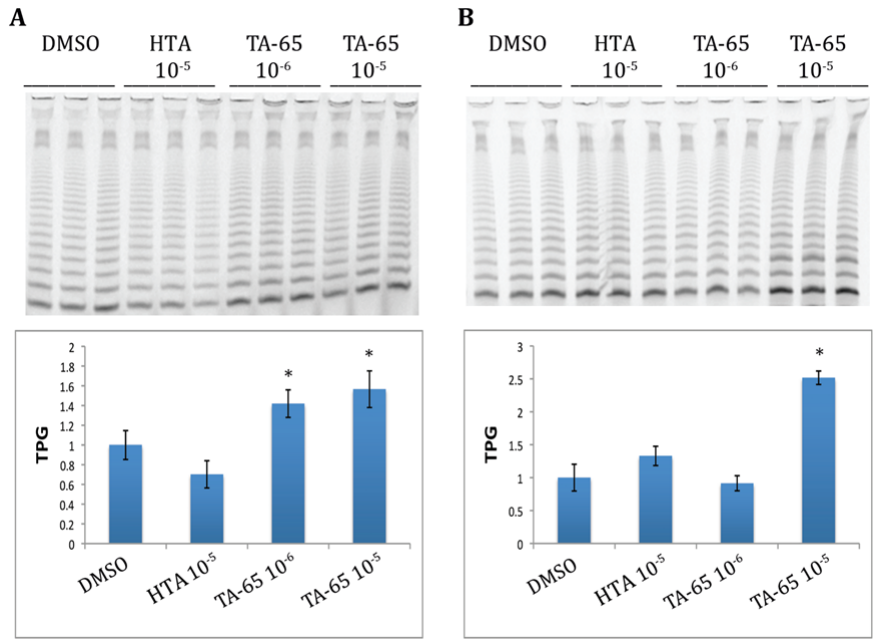
Figure 1. TA-65 and HTA treatment of CD4 T cells increases telomerase activity in response to primary ( A ) and secondary ( B ) cell stimulations. This figure shows representative results for cultures of purified CD4 T cells from a single donor that were exposed to either TA-65, HTA or DMSO (triplicate cultures for each condition). Top portion of Figure 1A,B illustrate the band products of telomerase activity indicated as TPG (TPG is total product generate, a measure of telomerase activity). Dark bands indicate high telomerase activity. The bottom portions of panels A and B represent quantization bar graph values for the enzyme activity. The average DMSO TPG was used to normalize telomerase activity between treatments. The total dilution of compounds in grams/mL is indicated above the lanes and below the bar graphs. Statistical significance was determined by student paired t test ( p < 0.05).